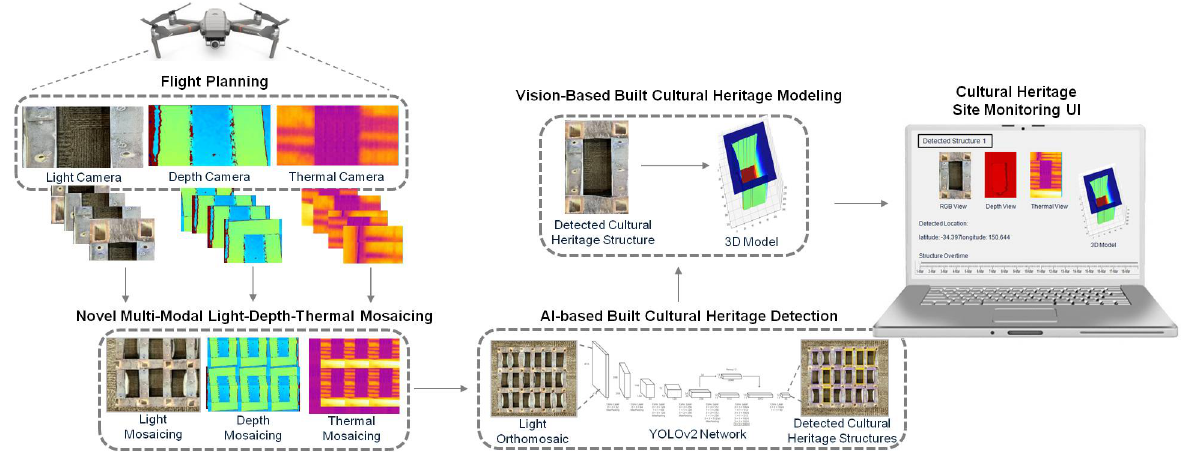
Figure 5. Proposed archaeological aerial monitoring system